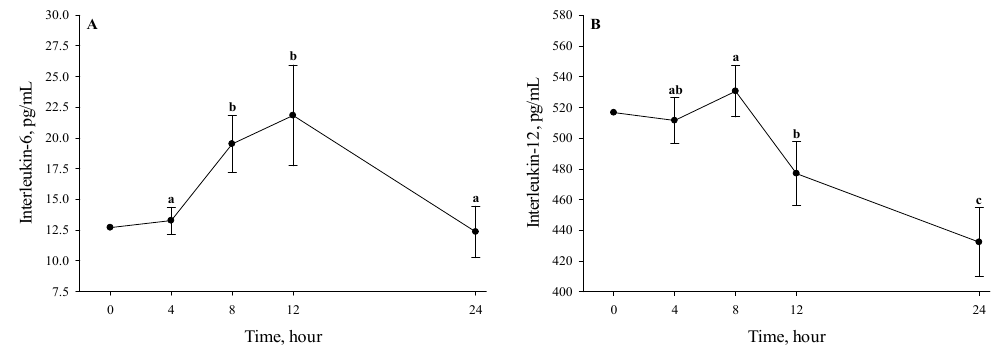
Figure 4. Effects of 24 h temperature and feeding treatment on ( A ) serum interleukin-6 and ( B ) serum interleukin-12 measured every 4 h in finishing pigs. Error bars indicate ± 1 SEM. Letters a and b indicate hourly differences ( p < 0.01). Hour 0 data are for descriptive purposes only.